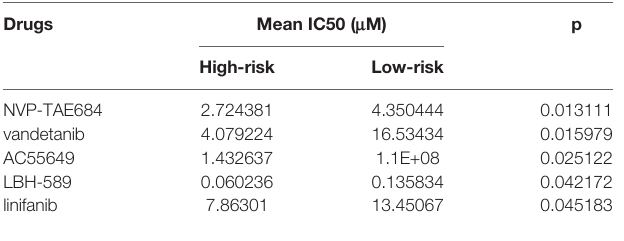
TABLE 4 | Comparison of the drug sensitivity between high- and low-risk groups.